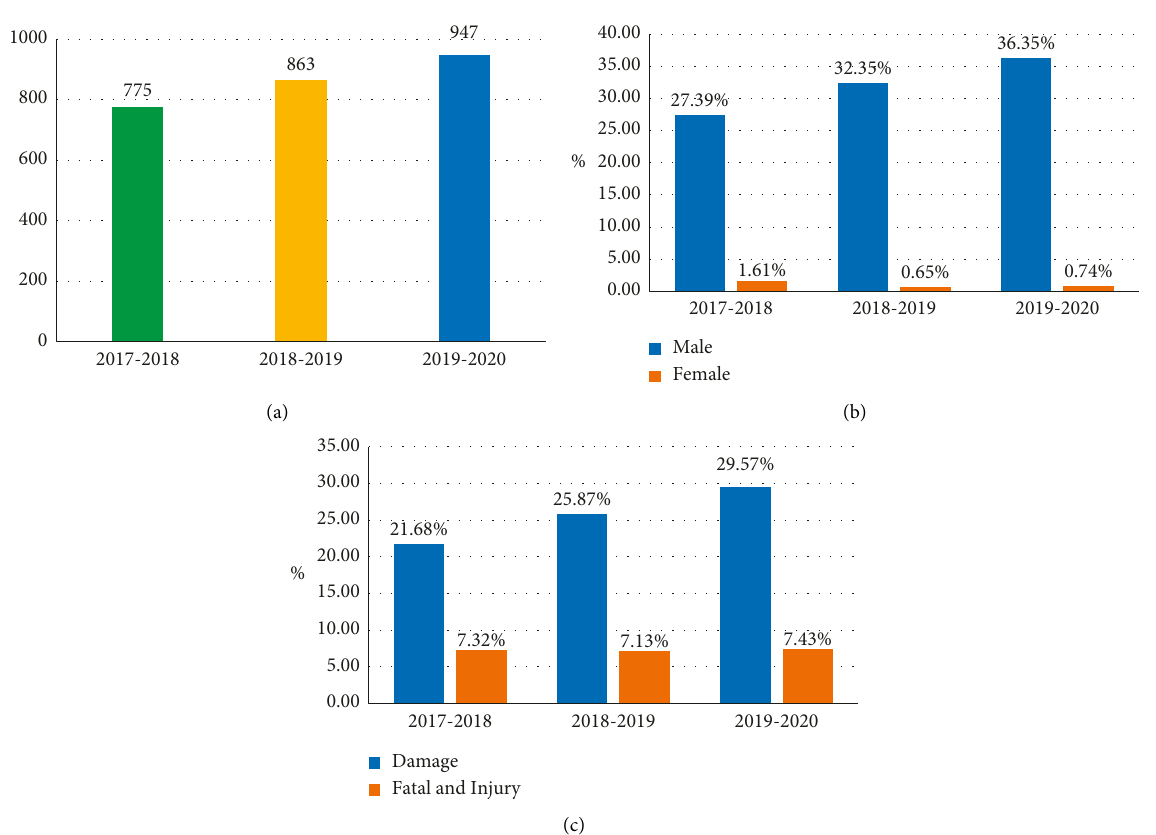
Figure 1: Statistics of vehicle accidents based on: (a) accident year, (b) severity of accidents and accident year, and (c) gender of the driver and accident